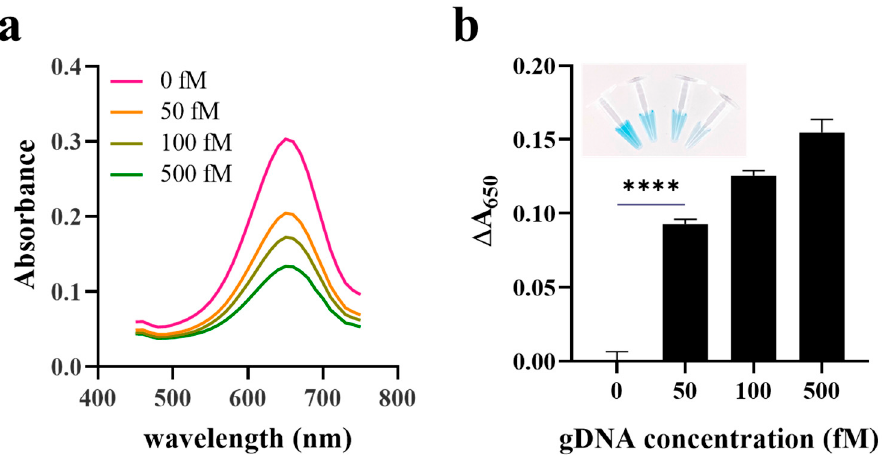
Figure 7. Direct detection of gDNA extracted from Klebsiella pneumoniae . ( a ) Absorbance spectra and ( b ) ∆ A 650 in the presence of extracted gDNA at different concentrations. Change in absorbance signal ( ∆ A 650 ) was calculated by subtracting A 650 in the presence of extracted gDNA from that in the absence of extracted gDNA. p value is indicated by stars, **** p < 0.0001. Inset shows a photographic image of each sample containing extracted gDNAs at different concentrations.